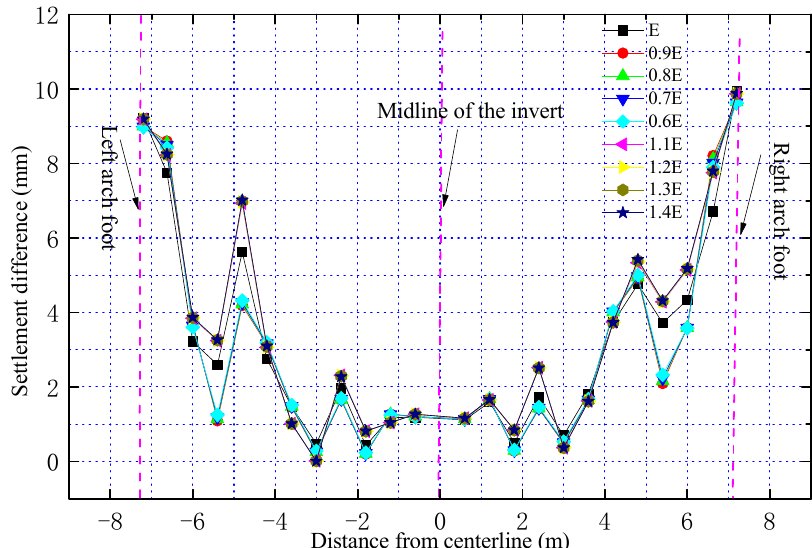
Figure 12. Layout of foundation pile.